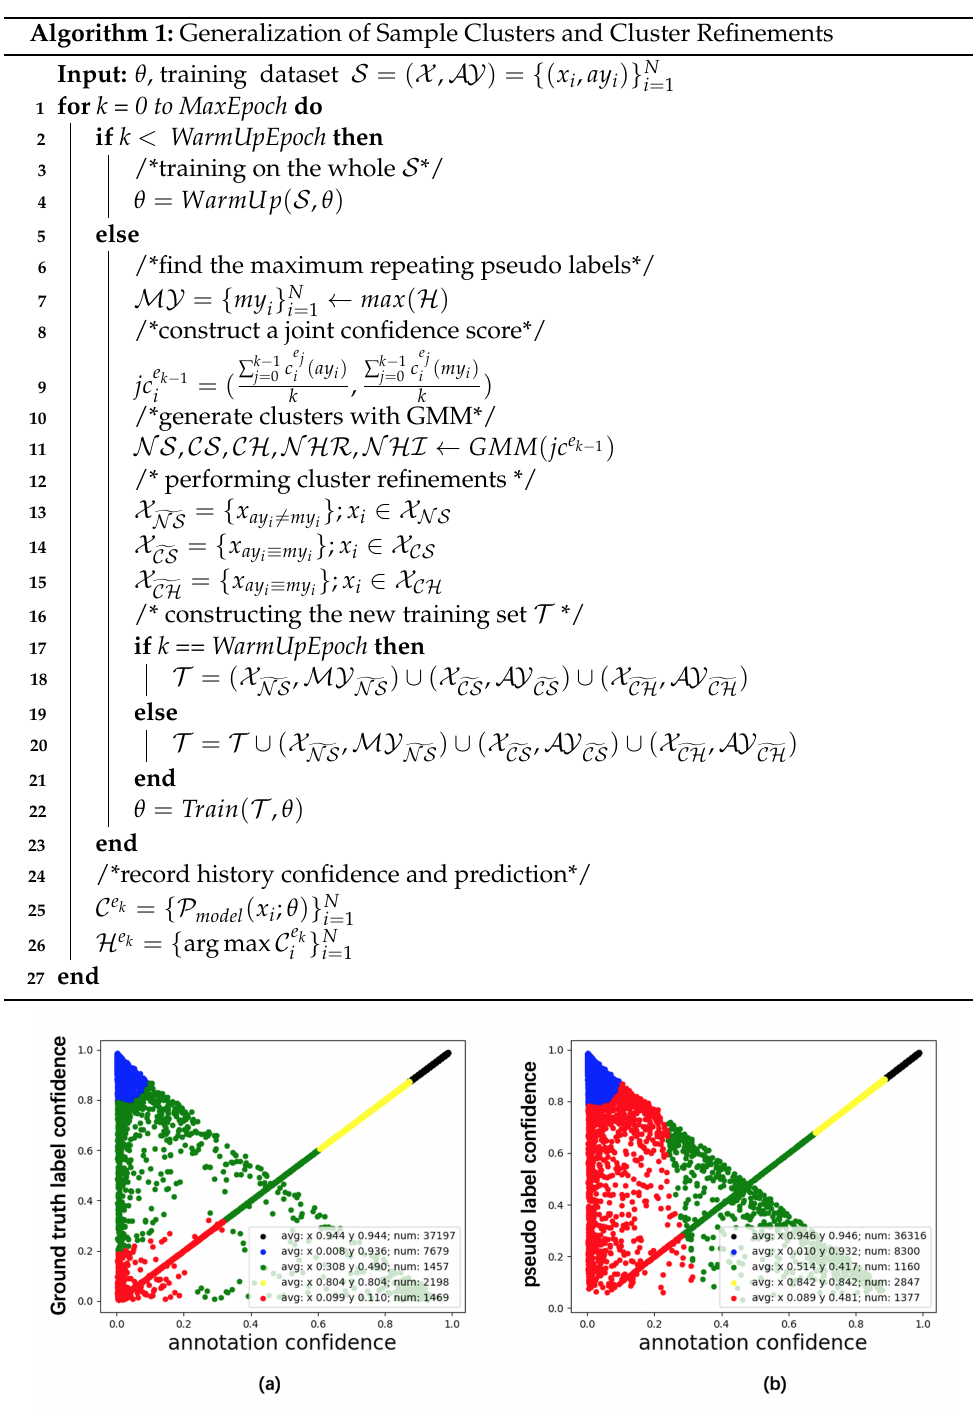
Figure 2. Sample clusters generated by FGCM. ( a ) is generated using confidence score of ground truth labels and annotation labels. ( b ) is generated using confidence score of maximum repeating pseudo labels and annotation